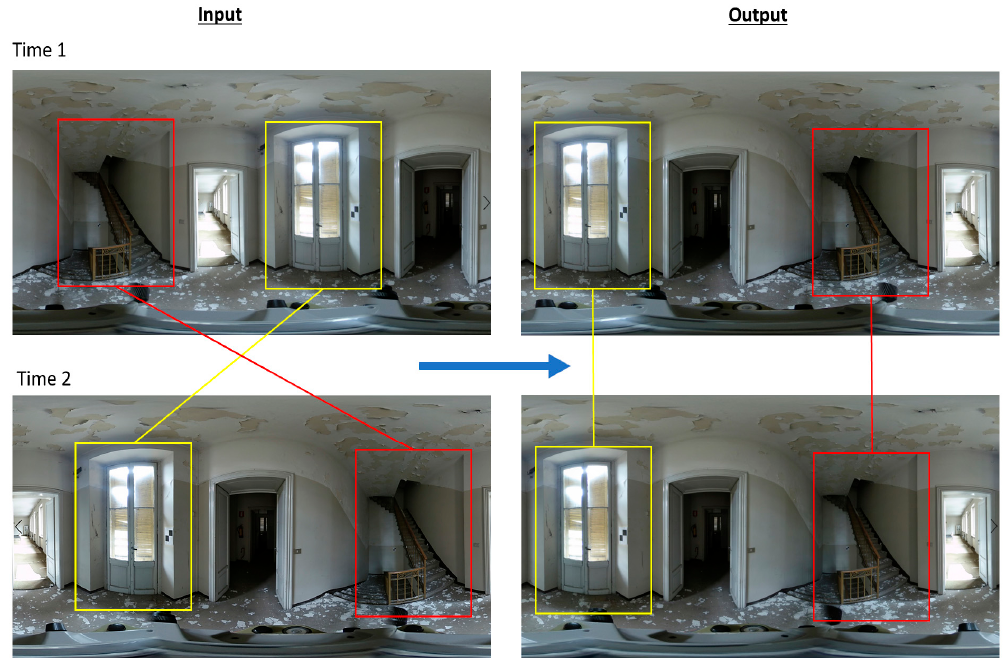
Figure15. Figure 15. The registration procedure and the results before and after recovering pixel-to-pixel correspondence.